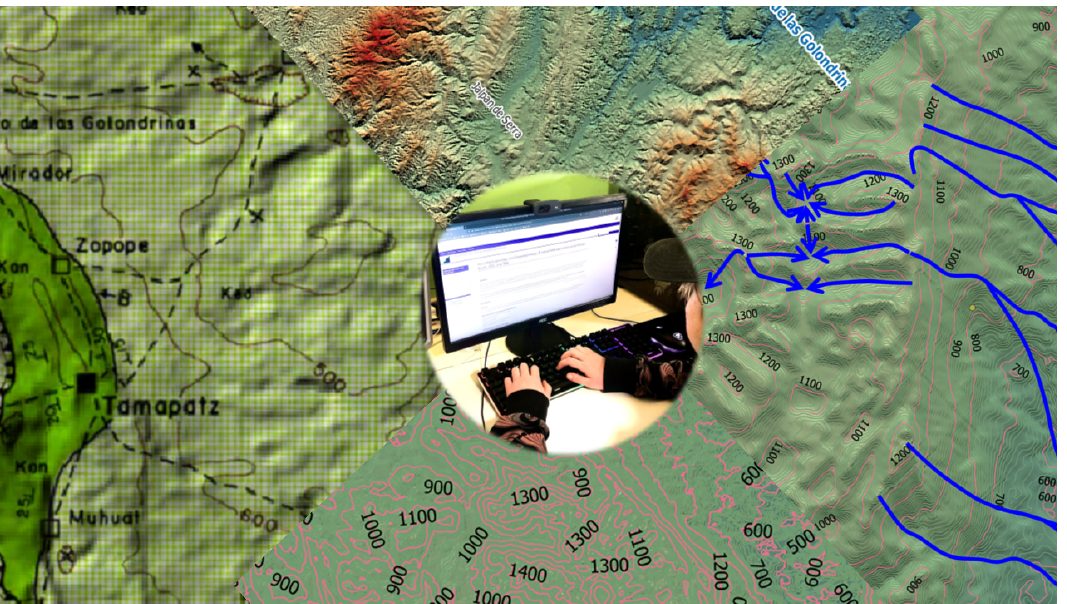
Figure 8. Advanced activity synthesis, clockwise from left, showing an analog geological map draped over topography using QGIS, DEM with Hillshade in QGIS, a manually drawn flow routing, and the elevation contour layers in QGIS. Photo by the